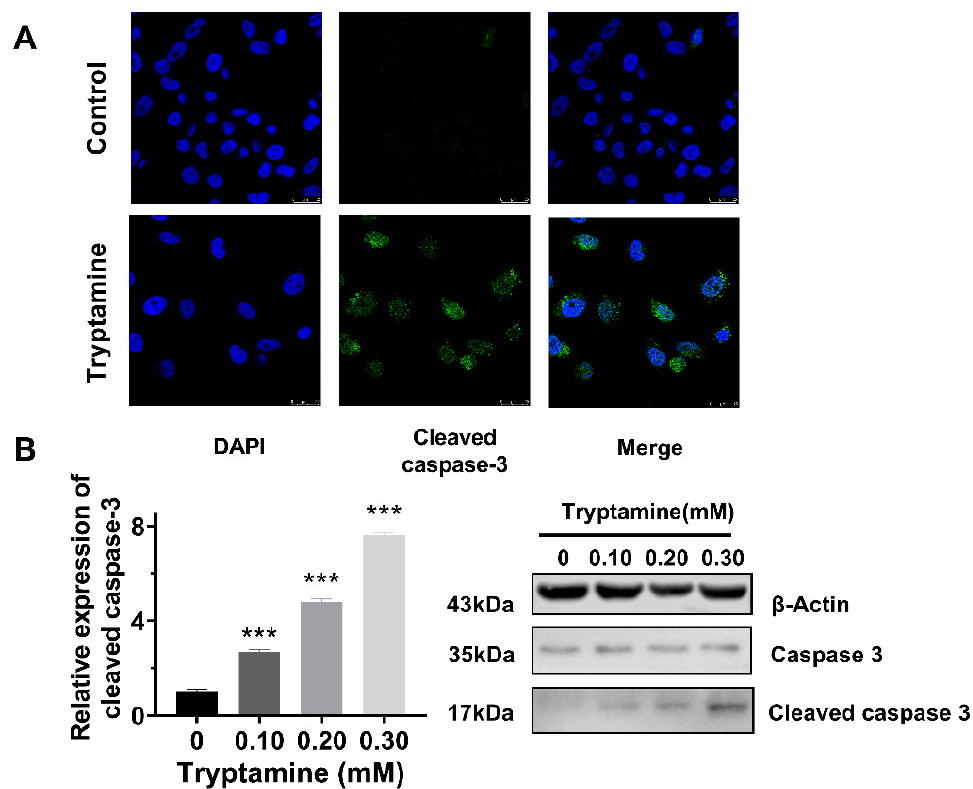
Figure 6. Tryptamine-induced PC-3 cell apoptosis via caspase-3 pathway verified by confocal imaging and Western blot. ( A ) Confocal imaging of cleaved caspase-3 (green) and DAPI (blue) after incubation with 0.3 mM tryptamine for 8 h. ( B ) Expression of cleaved caspase-3 protein in PC-3 cells after incubation with various concentrations of tryptamine assessed by Western blot assay. *** p < 0.001.